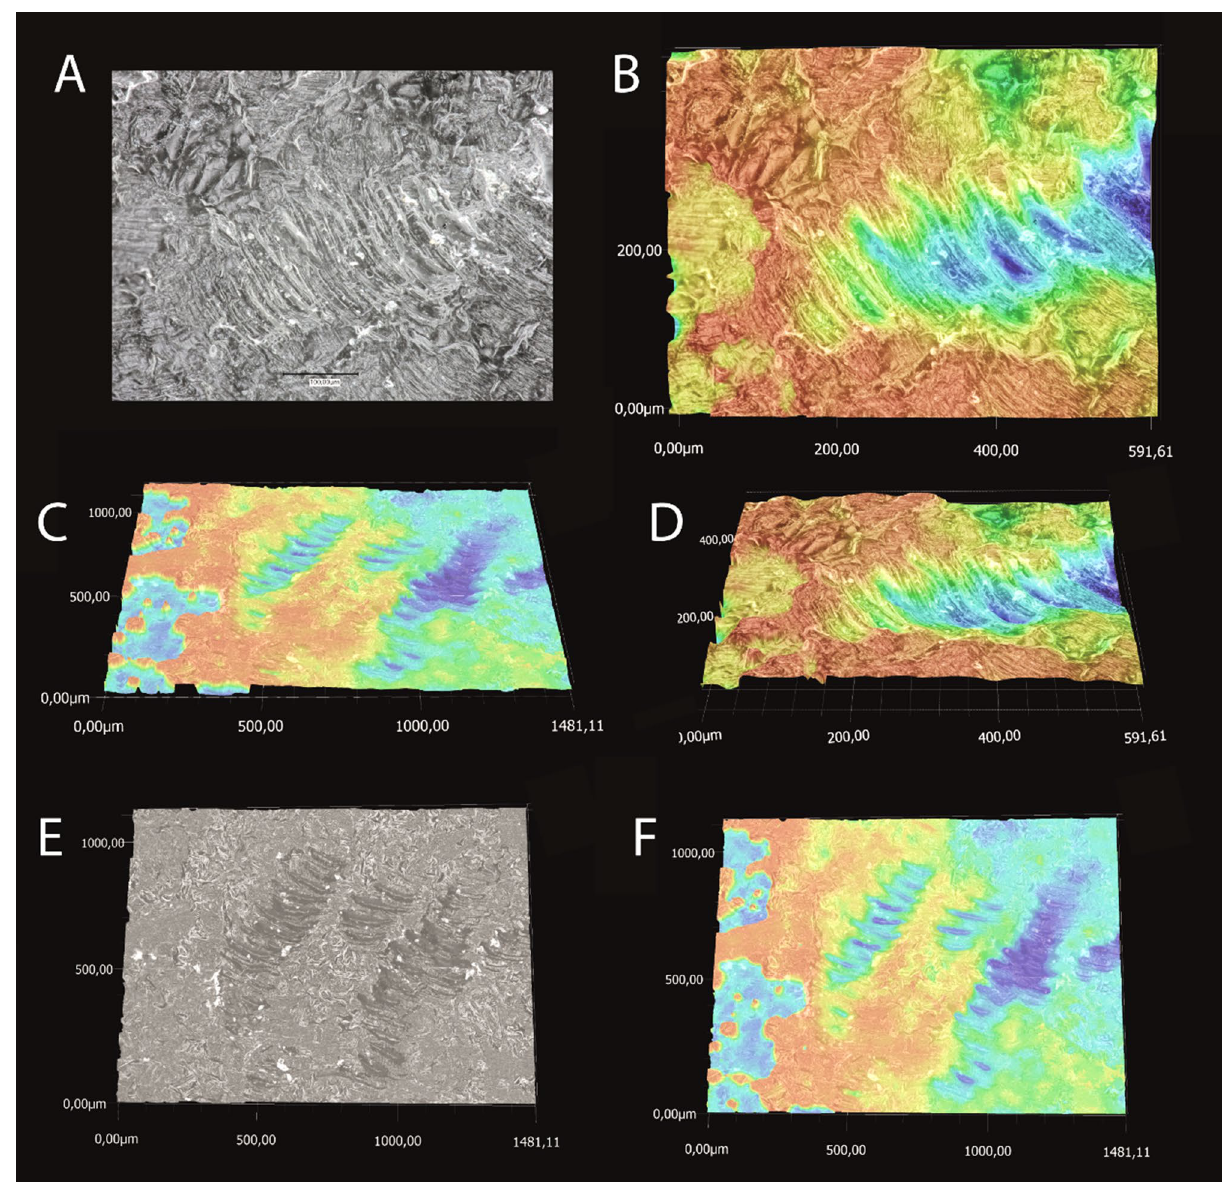
Figure 11. Feeding tracks left by gastropods on paraffin surface. Only the traces of lateral tooth II cusps are clearly visible. ( A – C ) Feeding track I from different perspectives: ( A ) Stacked image in SEM optic; ( B , D ) Colored surface texture visualized with Keyence VHX-7000. ( C , E , F ) Feeding track II from different perspectives: ( E ) Stacked image in SEM optic; ( C , F ) Colored surface texture visualized with Keyence VHX- 7000. Dimensions are given in